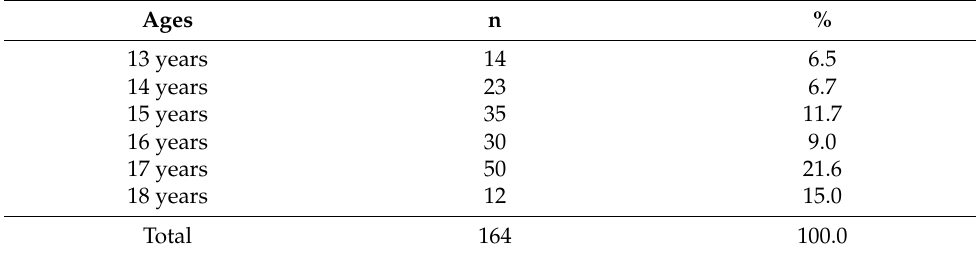
Table 3. Distribution of the passed test based on age